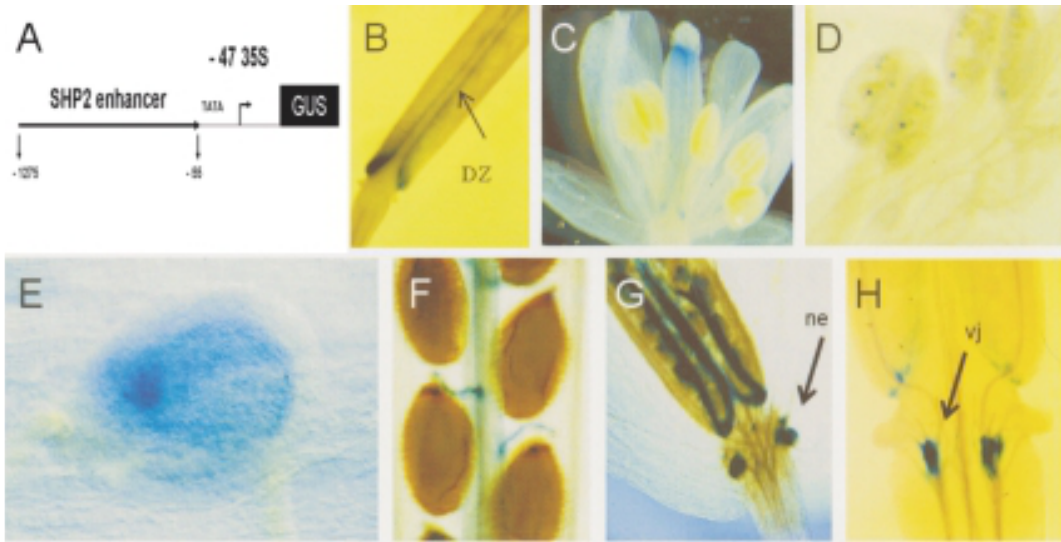
Figure 1 - GUS expression pattern in Arabidopsis plants containing the construct SHP2 fused to the minimal 35S promoter ( -47-35S::GUS) . (A) Sche- matic representation of the construct (which is not drawn to scale). (B) Arabidopsis silique showing GUS expression in the dehiscence zone (DZ, arrow). (C) A young flower with GUS expression in the DZ. GUS expression is also present in (D) pollen grains, (E) ovules, (F) funiculus and (G) nectary (ne), and (H) vascular junction (vj) in the